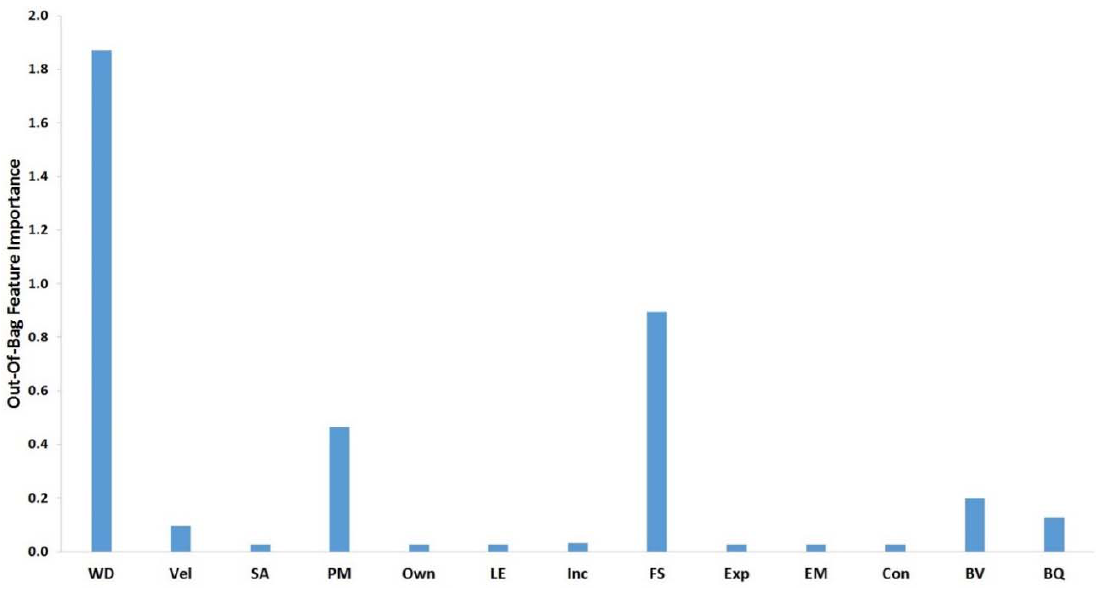
Figure 10. Out ‐ of ‐ bag feature importance for bagging decision trees. Figure 10. Out-of-bag feature importance for bagging decision